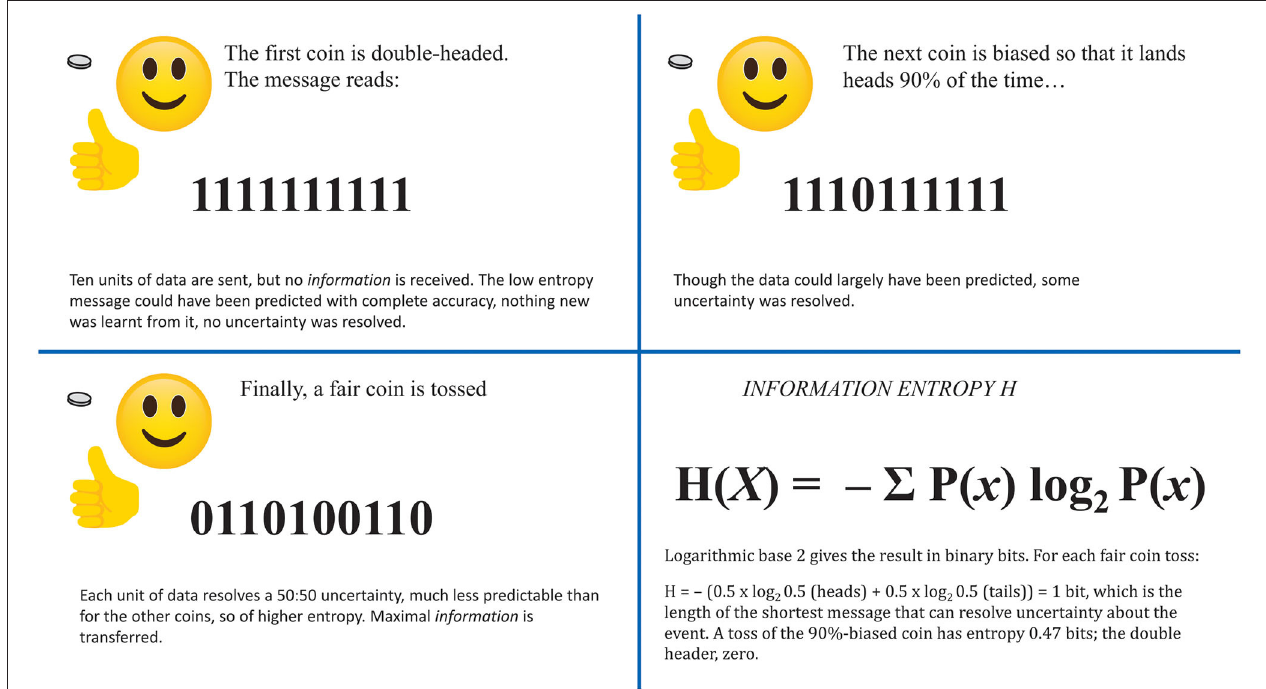
FIGURE 3 | Three coins have known but different probability profiles. Each is to be tossed 10 times. A sender wants to transmit the results in a binary stream, 1 = heads, 0 = tails. Bottom right: a general expression for information entropy H takes the probabilities P ( x ) of the outcomes of a variable X .